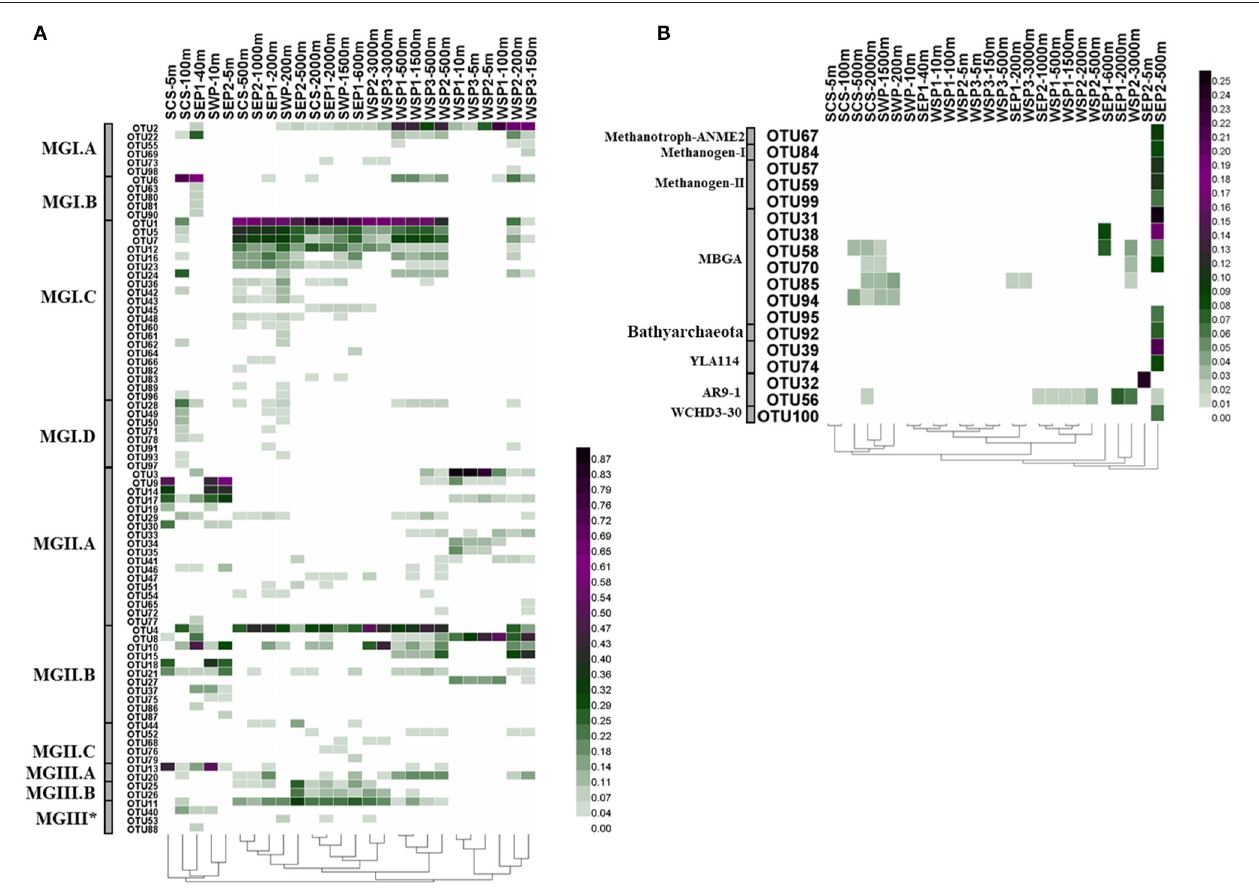
FIGURE 5 | Heatmaps showing the distribution of the top 100 abundant OTUs in the various samples. (A) OTUs are classified as MGI, MGII, and MGIII archaea. (B) OTUs are affiliated with Methanotroph-ANME2, Methanogen-I, Methanogen-II, MBGA, Bathyarchaeota, YLA114, AR9-1, and WCHD3-30. The color bar indicates the relative abundance of each OTU (square root transformed). The classification of each OTU was based on the data shown in Figure 4 . MGIII* indicates OTUs not included in MGIII.A and